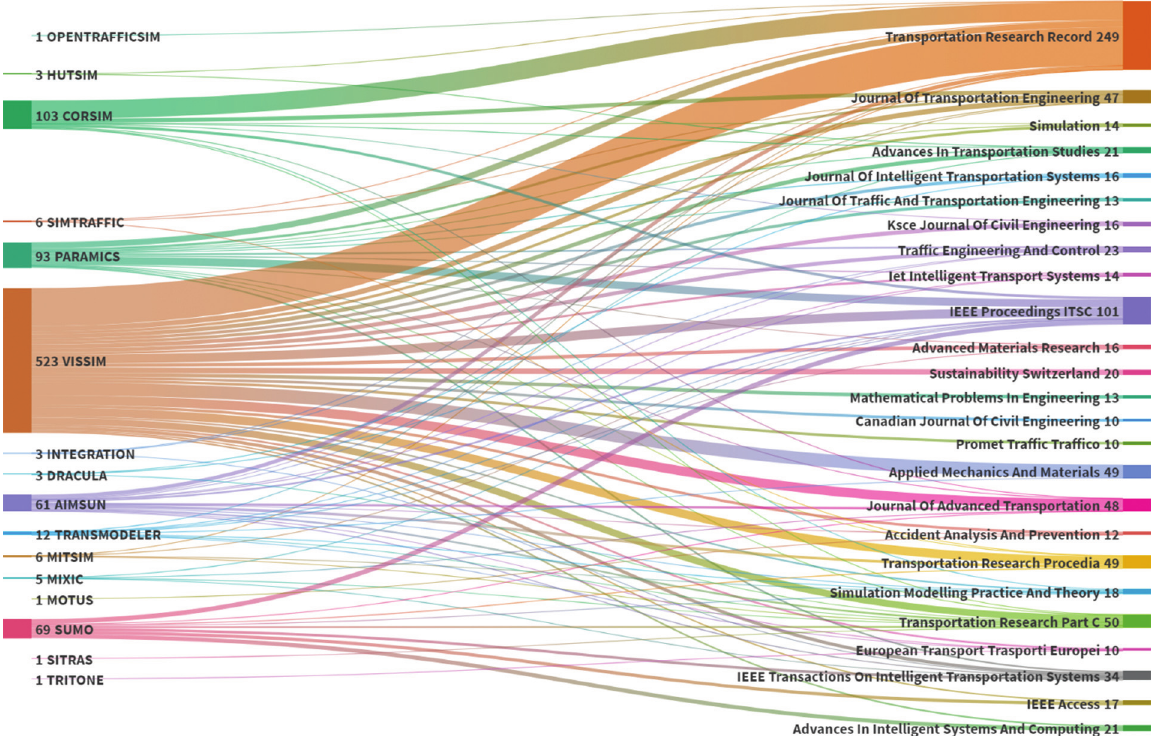
Figure 5: Publication shares of microsimulation platforms over top 25